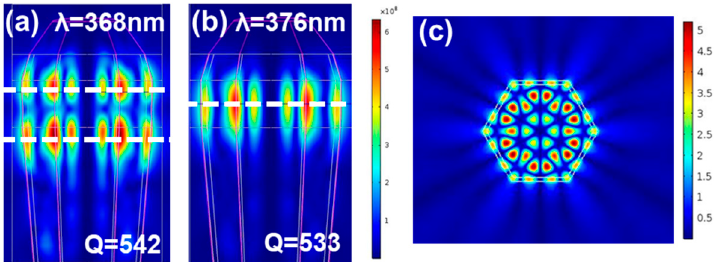
Figure 3. The side-view mode intensity profile of the ( a ) 368 nm and ( b ) 376 nm mode in a single rod whose geometry followed the parameters extracted from SEM and TEM images of Figure 1; ( c ) the mode intensity profile acquired from the white dashed line cross-sections in (a,b).